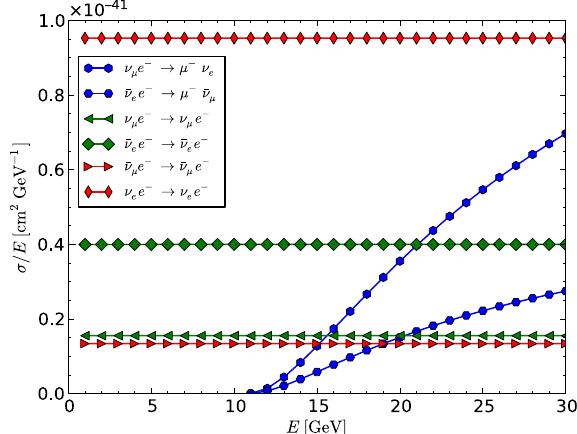
FIG. 3. Total cross section divided by neutrino energy for the leptonic interactions in a neutrino factory beam. Hexagon markers show CC interactions, triangle markers show NC interactions, and rhomboid markers show mixed CC þ NC interactions. The threshold for quasielastic processes (1) (blue) is evident at (cid:2) 11